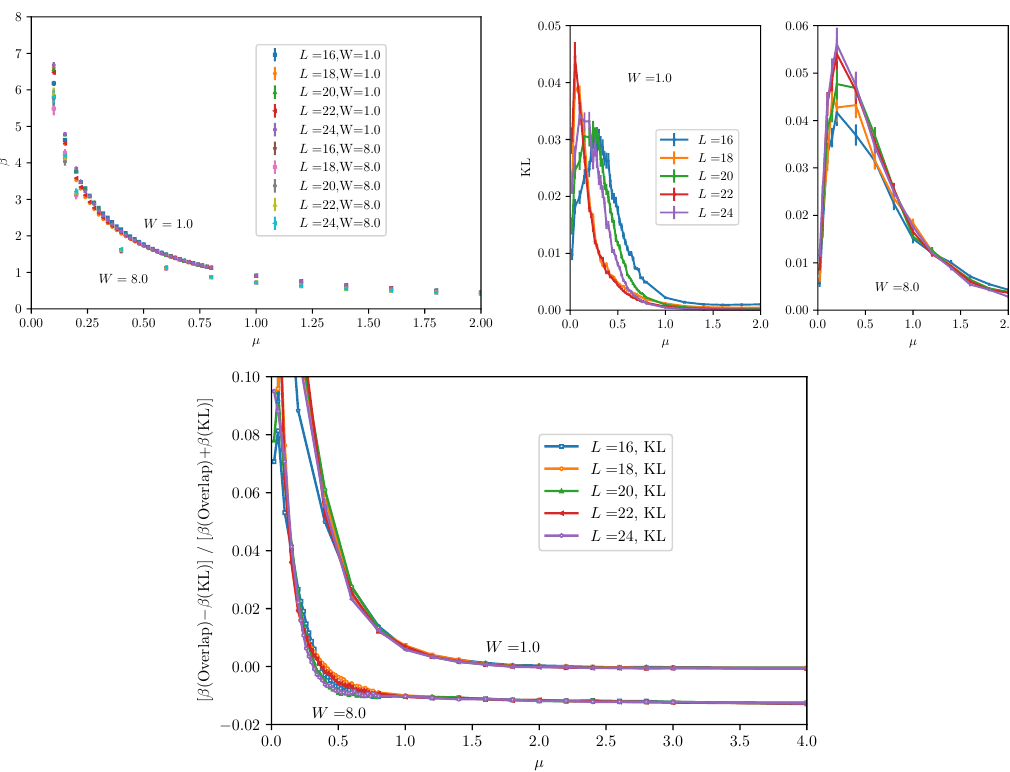
Figure 4 . Various quantities as a function of coupling µ , for two disorder values ( W = 1 in the ergodic phase, W = 8 in the Many-Body Localized phase) and for different sizes L , averaged over more than 100 realizations of disorder. [Top, left] The optimal inverse temperature β = β ( µ ) which maximizes the overlap. [Top, right] The KL-divergence. [Bottom] Normalized difference between the inverse temperatures β (overlap) and β (KL) as determined from the maximization of the overlap or the minimization of the KL